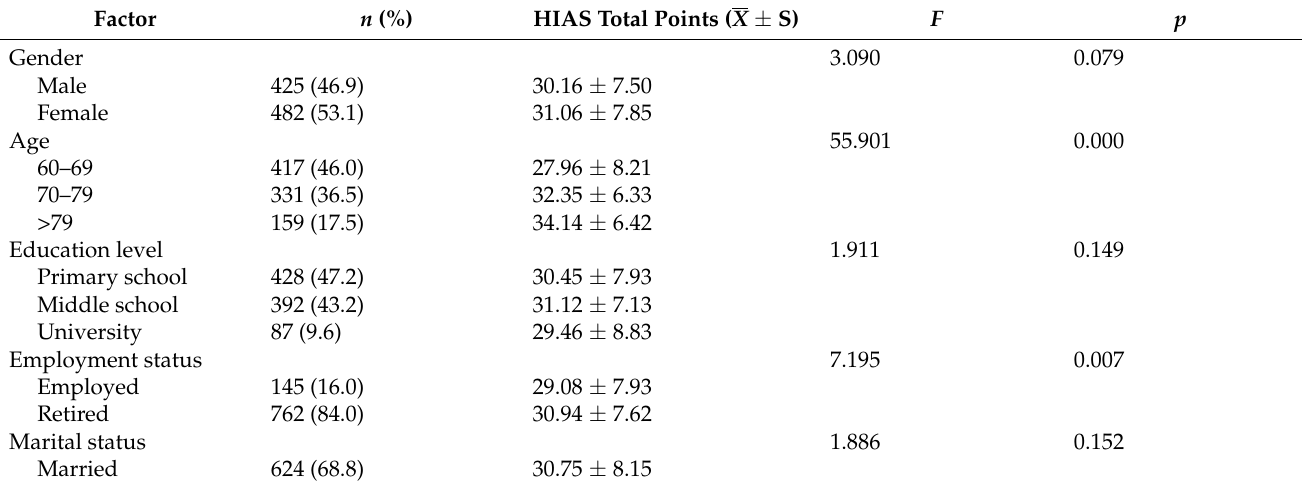
Table 3. Comparison of different sociodemographic elderly people’s COVID-19 information avoid- ance ( n =